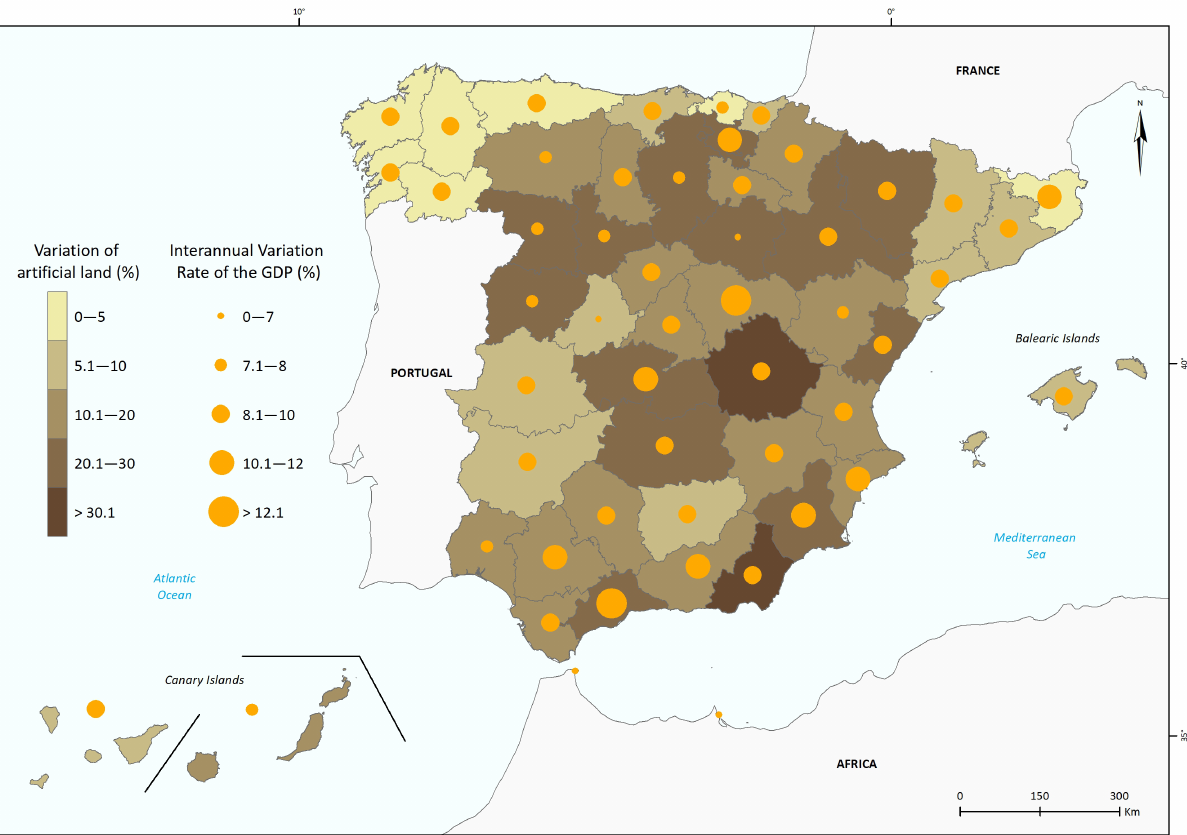
Figure 1. Variation of artificial land (2000–2006)% (source: Digital Atlas of Urban Areas [15]) and Interannual Variation Rate of the GDP (2000–2006)% (source: National Accounts of Spain: Main Aggregates (QNA). Spanish Institute of Statistics (INE) [16]). Author’s